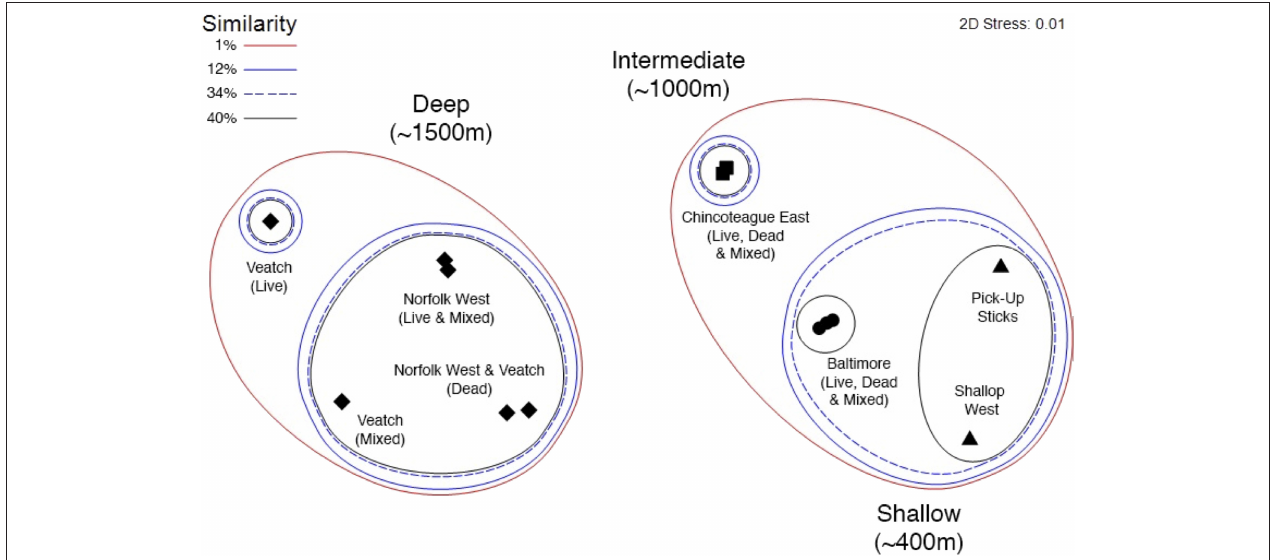
FIGURE 5 | Non-metric multidimensional scaling (MDS) ordination from photo transect data. Symbols represent the four clusters identified by the similarity profile routine (SIMPROF test): (i) Norfolk West and Veatch (diamonds), (ii) Chincoteague East (squares), (iii) Baltimore (circles), (iv) Pick-Up Sticks and Shallop West (triangles). Parentheses: habitat type [i.e., live, dead, and mixed (live and dead) mussel coverage].